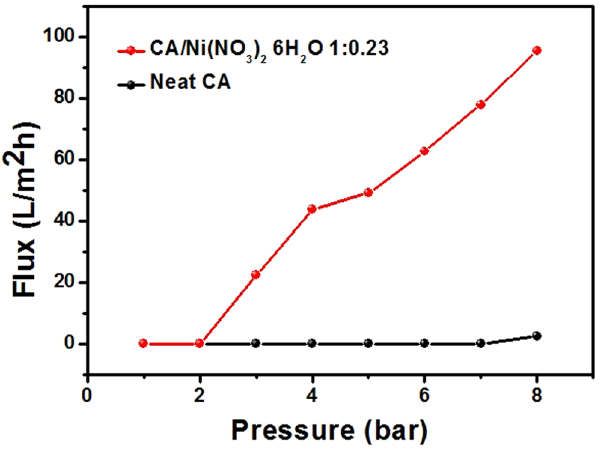
Figure 2. Flux measured through neat cellulose acetate (CA) and CA with Ni(NO 3 ) 2 ·6H 2 O at various water